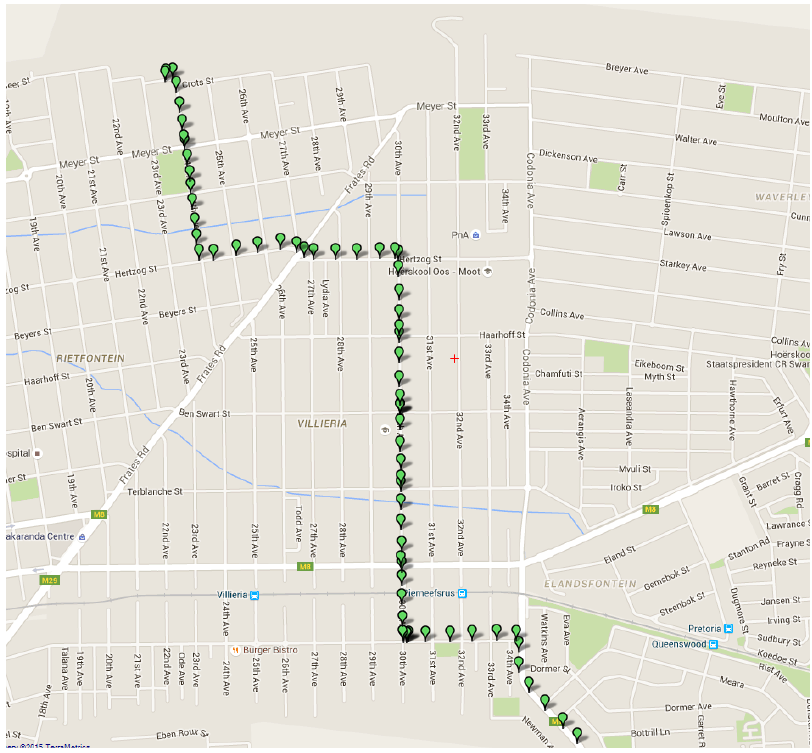
Figure 11. The retrieval, processing, and display of location information.